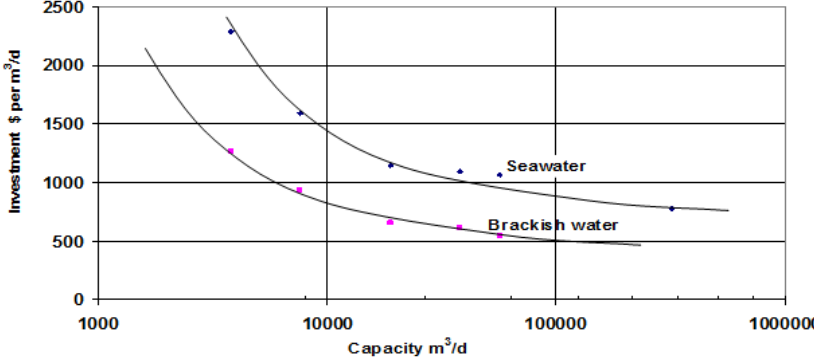
Figure 4. Investment cost/m 3 for seawater reverse osmosis (SWRO) and brackish water reverse osmosis (BWRO) systems. Note the reduction as the capacity